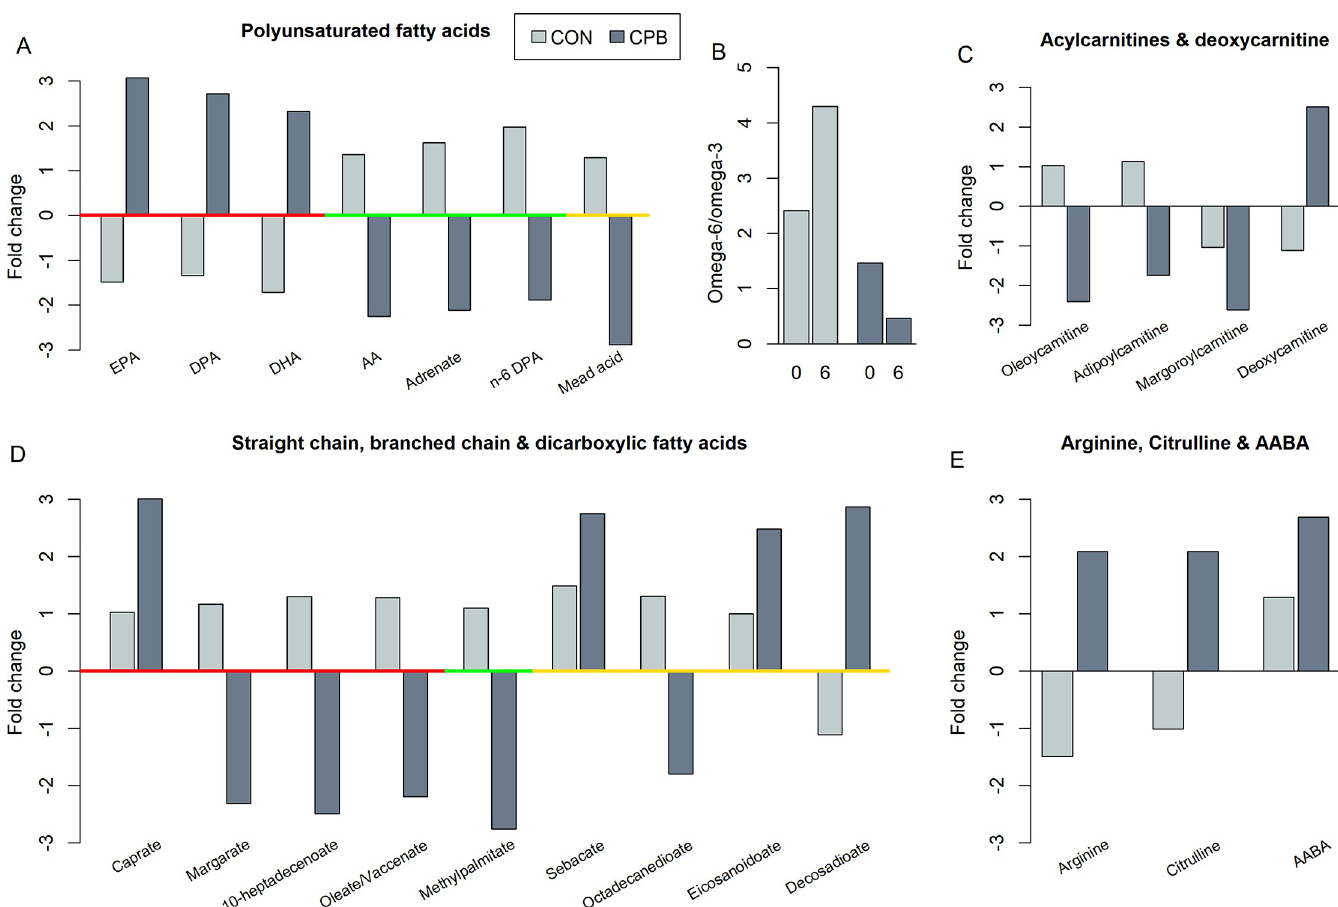
Fig 2. Fold changes between CPB vs. CON diets in (A) polyunsaturated FAs, (B) ratios of omega-6 to omega-3 FAs, (C) acylcarnitines and deoxycarnitine, (D) straight chain, branched chain, and dicarboxylic FAs, and (E) L-arginine, L-citrulline, and 2-aminobutyric acid (AABA) at baseline (0) and 6 months (6). Red, green, and gold bars along x-axis depict (A) omega-3, -6, and -9 FAs respectively and (D) straight, branched chain, and dicarboxylic FAs respectively. A negative fold change represents a decrease from baseline to 6 months.